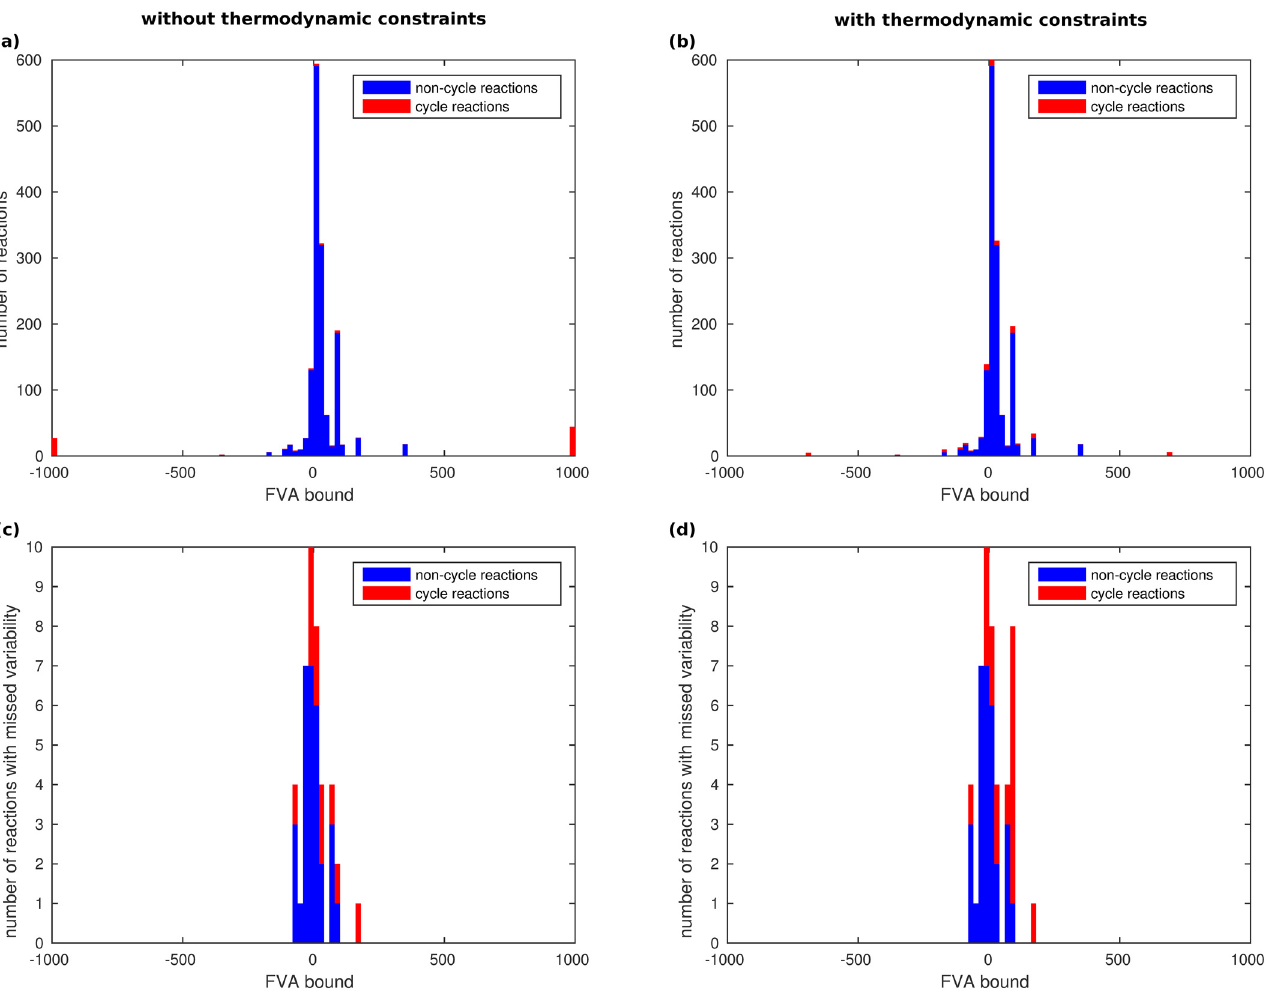
Fig 4. Distribution of E. coli iAF1260 flux variability that is missed by sampling. Histograms (a) and (c) are for the flux space without thermodynamic constraints, histograms (b) and (d) are with thermodynamic constraints. The bins in histograms (a) and (b) count the number of reactions with the respective lower and upper bounds computed by FVA. Bounds equal to 0 are not counted. Histograms (c) and (d) show, for the lower and upper bounds shown in (a) and (b), the number of reactions for which no negative resp. positive flux has been sampled. For all histograms, bin sizes of length 20 were chosen. We remark that zero flux is always possible. Therefore, the flux bounds directly relate to the possible flux